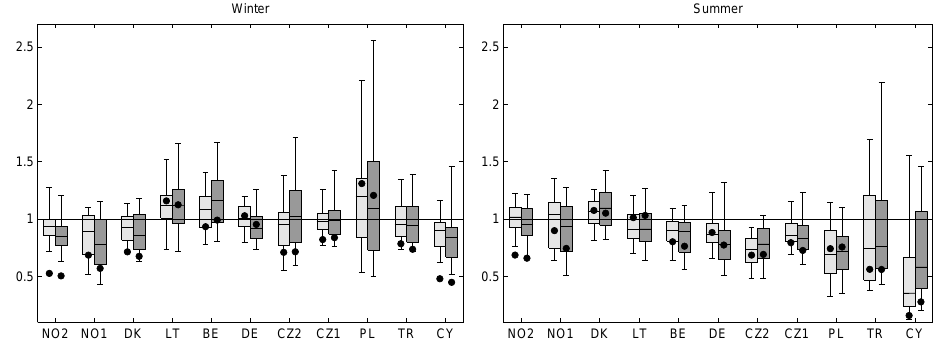
Figure 6. EPI estimated from the comparison of the observations and the downscaled time series by all BC methods for the control period for 1-year (light grey boxes) and 5-year levels (dark grey boxes). The boxes indicate the 25, 50, and 75th percentiles and the whiskers the 5 and 95th percentiles. The circles show the median of all the values of EPI estimated from the comparison of the observations and the uncorrected RCM outputs for the control period. All the results are for a temporal aggregation of 1